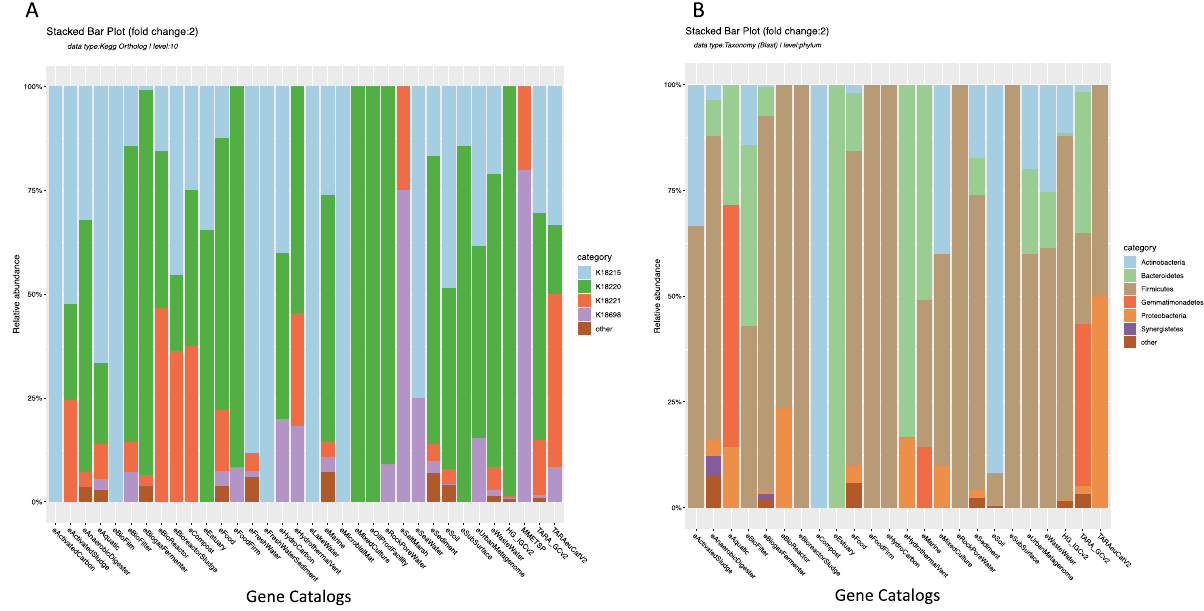
Figure 6. Antibiotic resistance genes. ( A ) Proportion of unique antibiotic resistance genes detected in different environments linked to tetracycline: tetV (K18215), tetM (K18220), tetX (K18221) and to beta lactamase class A: blaTEM (K18698). ( B ) Taxonomic affiliation of gene tetM in different habitats. See Supplementary Video SV4 to reproduce ( A ) in